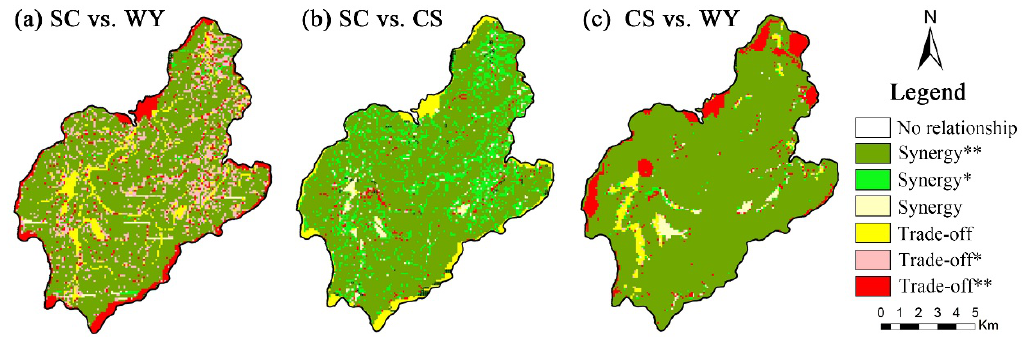
Figure 6. The spatial pattern of trade-off and synergy among three ecosystem services; ( a ) soil conservation and water yield; ( b ) soil conservation and carbon sequestration; ( c ) carbon sequestration and water yield. *: 0.05 < p < 0.10; **: 0.01 < p < 0.05.